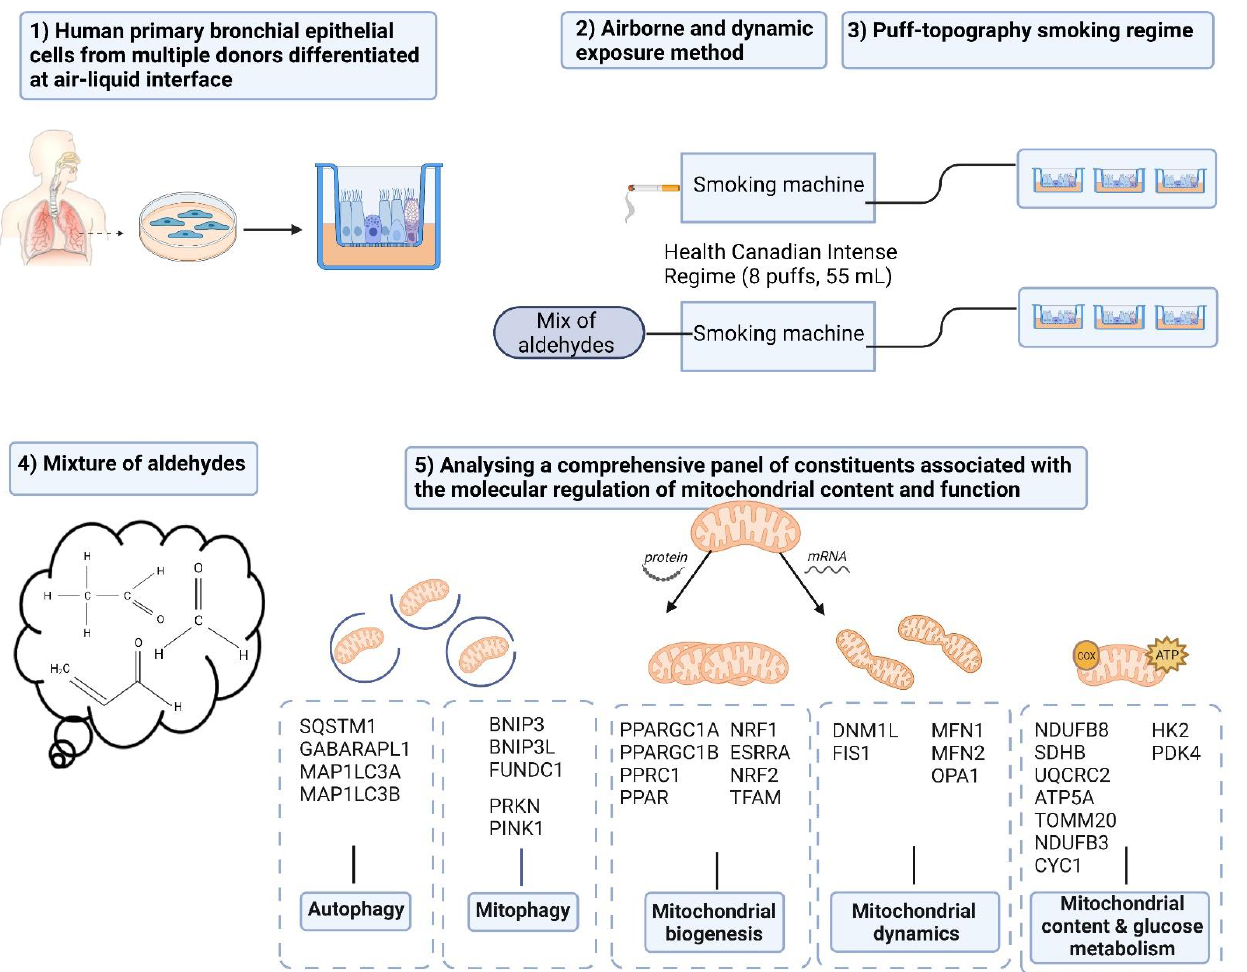
Figure 10. Schematic representation of the strengths and novelties of the study. (1) Use of human primary bronchial epithelial cells from multiple donors differentiated at the air – liquid interface. (2)